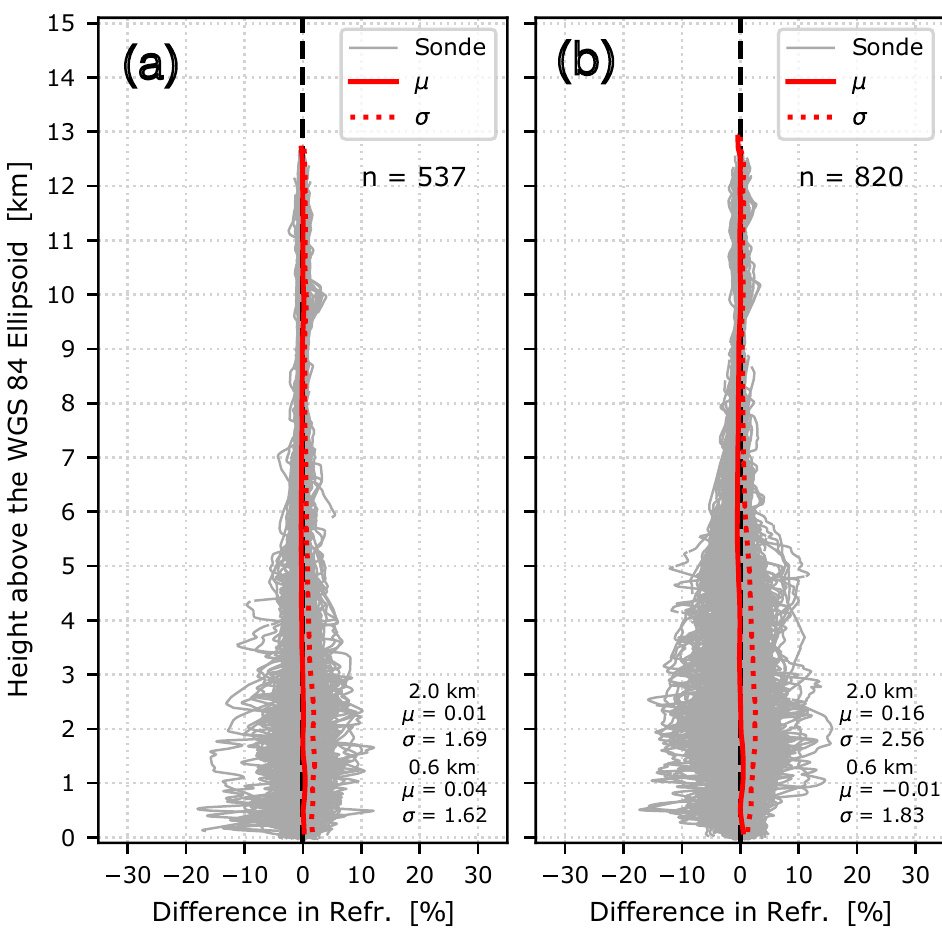
Figure 13. Statistical comparison between dropsondes collected during AR Reconnaissance that sampled ( a ) outside and ( b ) inside an atmospheric river and the ERA5 reanalysis product. The percent difference in refractivity (% of N) is shown between each dropsonde and its corresponding reanalysis profile (grey lines), along with the mean and standard deviation of these differences (solid and dashed red lines, respectively) computed in vertical bins with width of 200 m. The thick dashed black line highlights the line of zero difference and the number of dropsondes, n, is